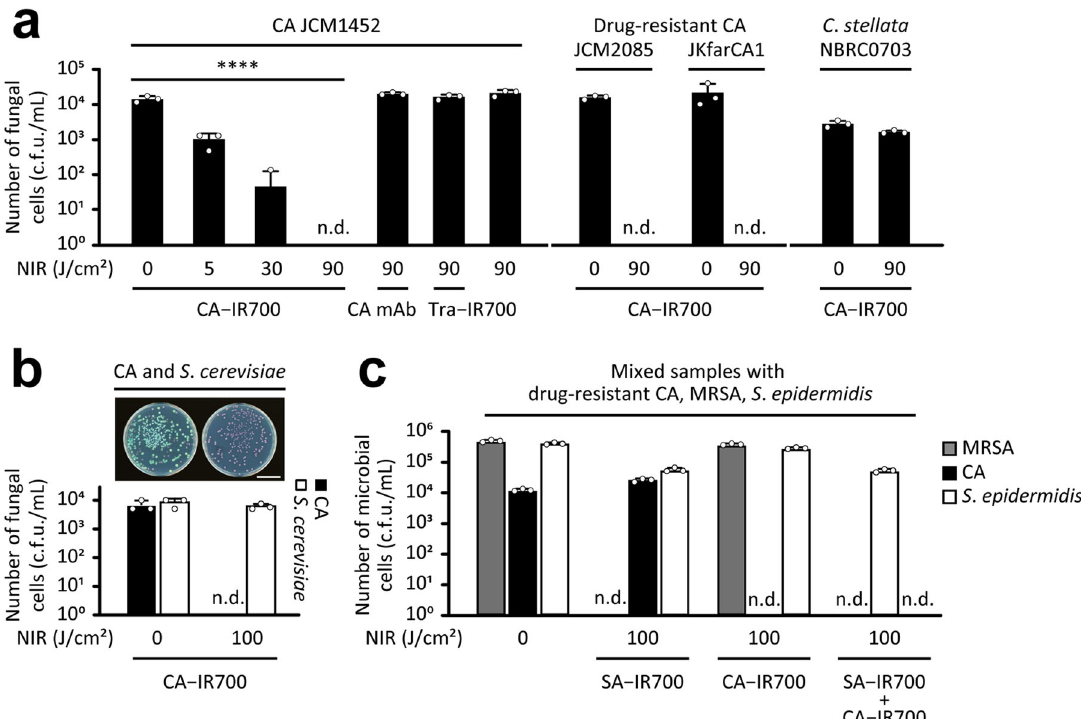
Fig. 3 Fungicidal effect of PIAS. a , b Effects of PIAS on a Candida albicans (CA), drug-resistant CA strains, and the non-target/non-pathogenic fungi Candida stellata and on b Saccharomyces cerevisiae . The scale bar indicates 3 cm in ( b ). c Target-selective microbicidal effect of PIAS using CA – IR700 and/or SA – IR700 conjugate(s) on a mixed sample of drug-resistant CA, MRSA, and the non-target/commensal bacterium Staphylococcus epidermidis . CA and S . cerevisiae formed turquoise-blue and mauve colonies, respectively. CA – IR700, 20 μ g/test; SA – IR700, 1 μ g/test; NIR near-infra-red light, c.f.u. colony- forming units, n.d. not detected, n.s. not signi fi cant ( p > 0.05). Mean and s.d. values are shown for triplicate samples; data were representative of at least three independent experiments. For statistical analyses, ANOVA with Dunnett ’ s test was performed. **** p <